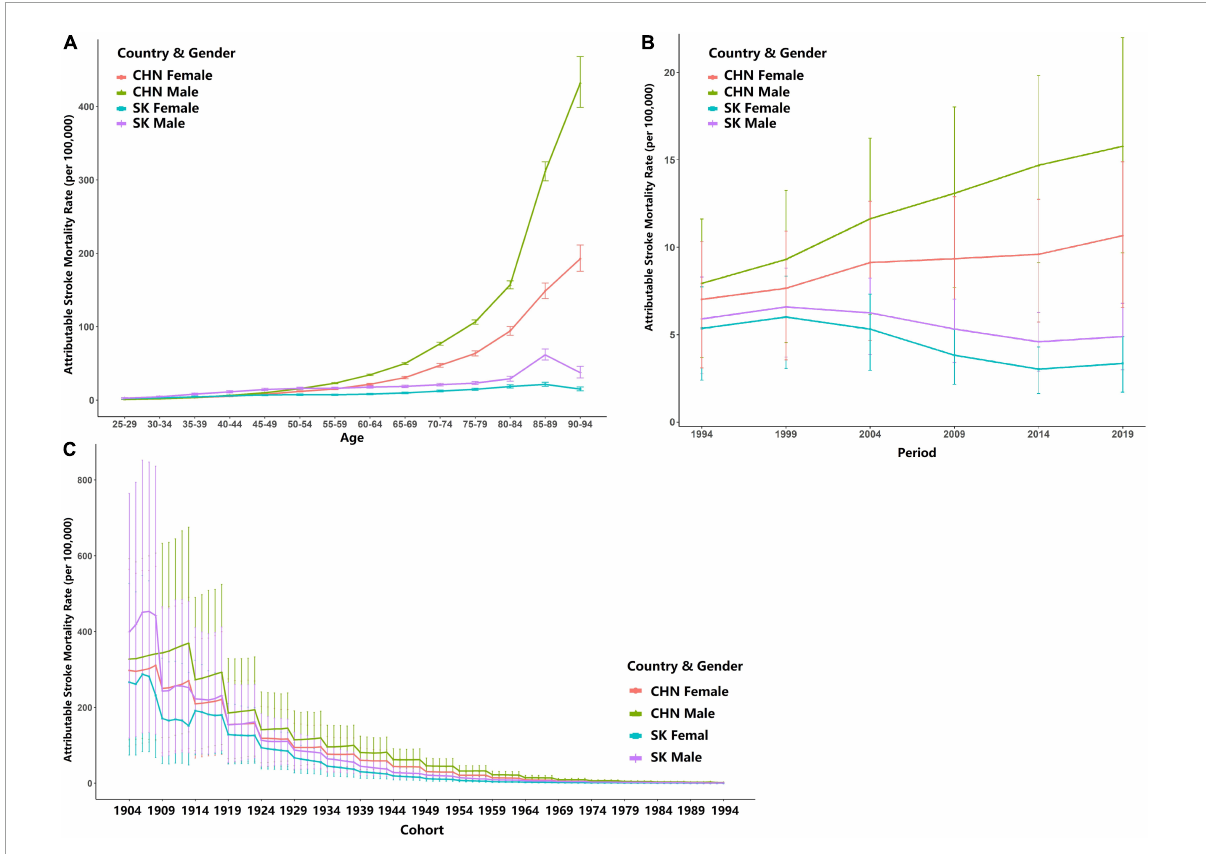
FIGURE3 Longitudinal curve for age, time period, and birth cohort for both genders in China (CHN) and South Korea (SK). (A) Longitudinal age curves; (B) longitudinal period curve; (C) longitudinal cohort curve (error bars stand for 95% confidence intervals).